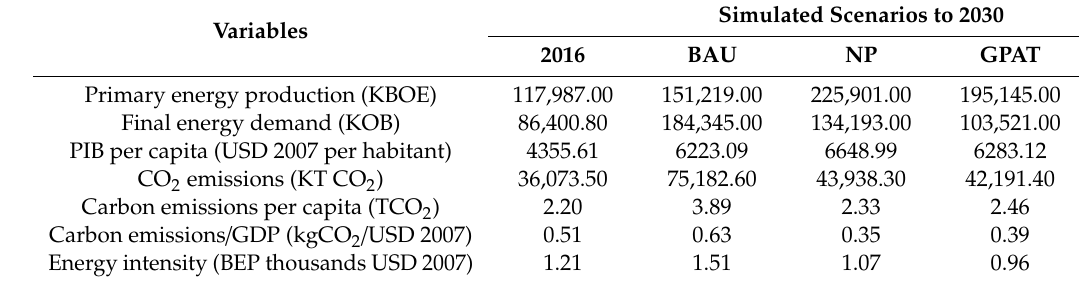
Table 1. Results obtained through the dynamics model for different energy variables and CO 2 emissions for 2016 and the Business as Usual (BAU), National Policies (NP) and Global Policies and Trends (GPAT) scenarios for 2030.